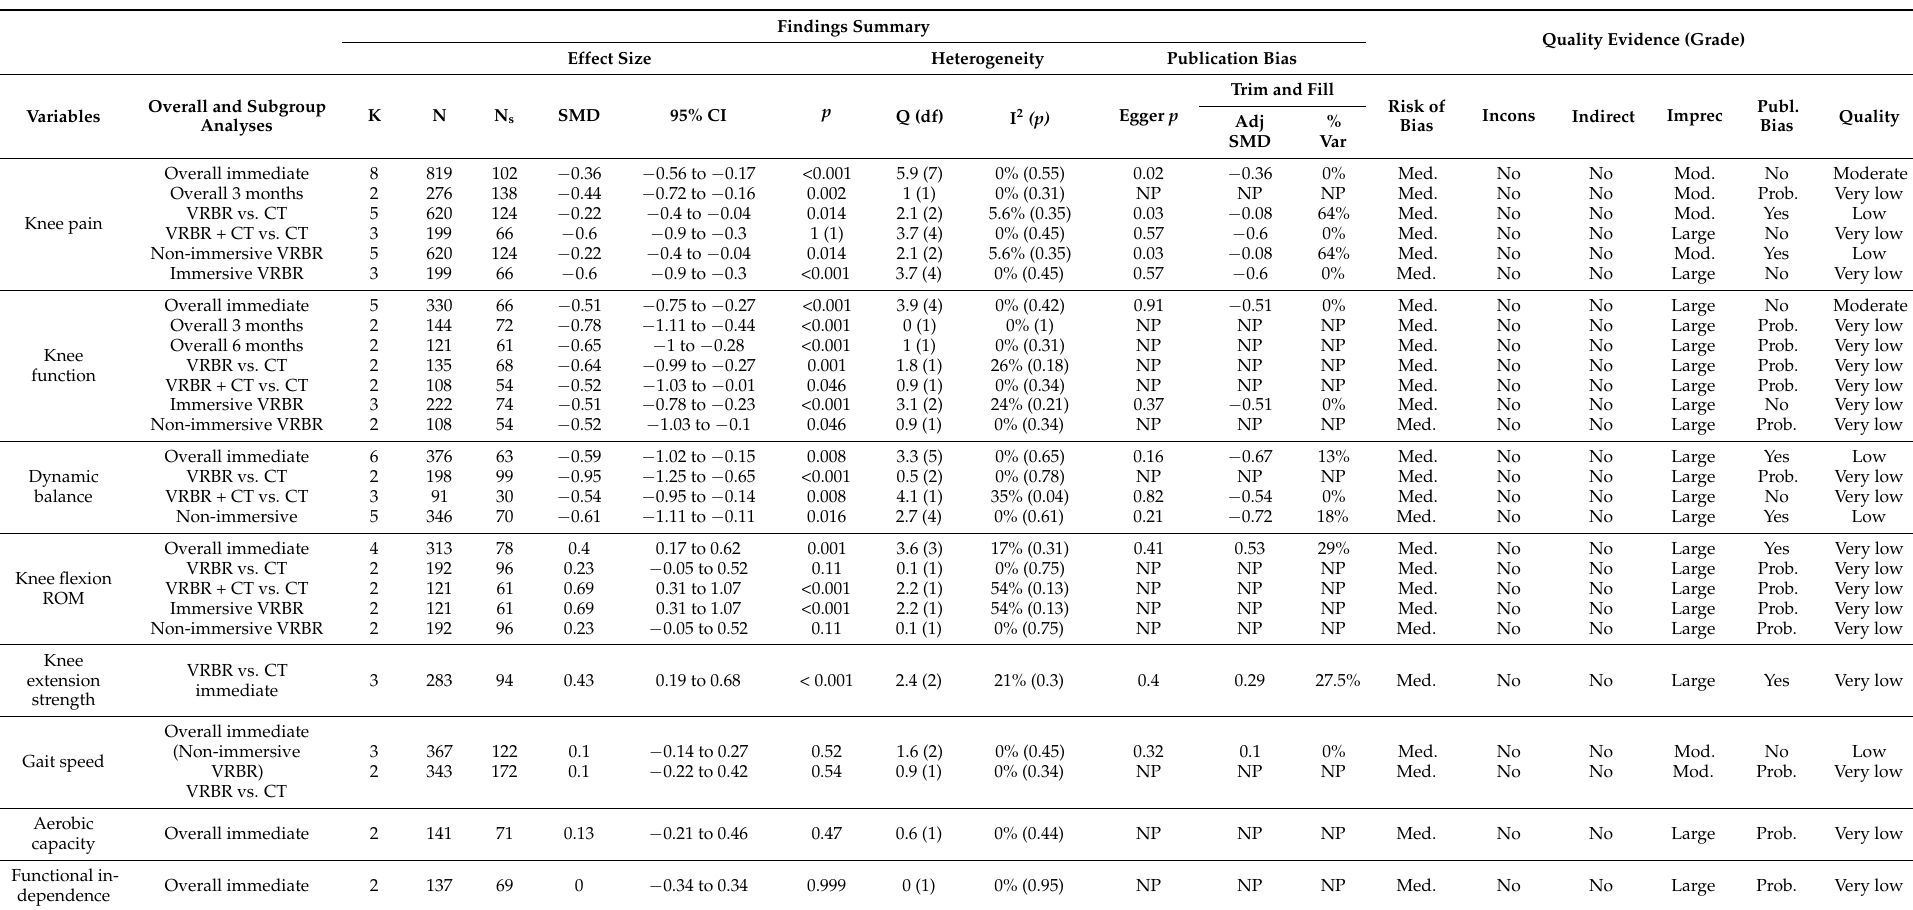
Table 4. Main findings of